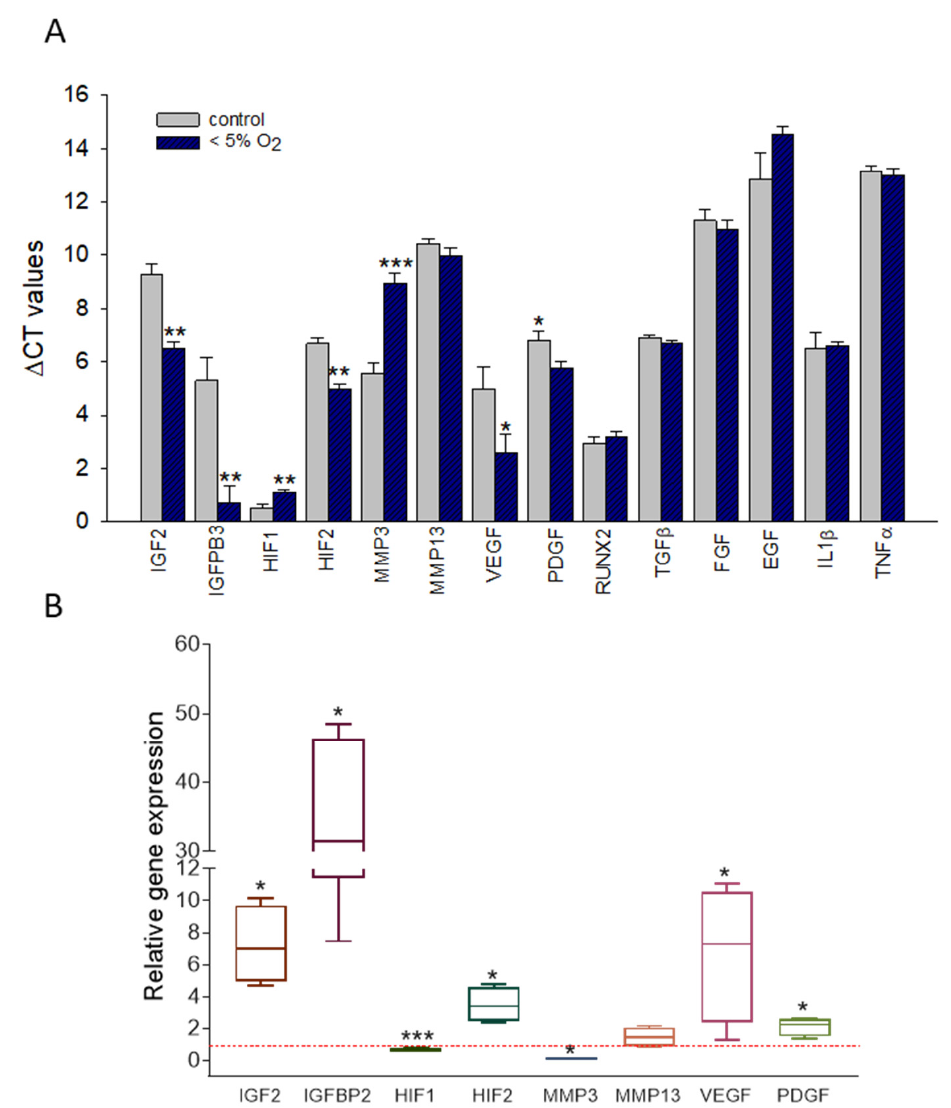
Figure 4. Evaluation of hypoxia induced changes in expression within the chondrocyte test system. The bar chart represents the averaged ∆ CT values of specific targets under normoxic and hypoxic conditions ( A ). Statistically significant differences, evaluated by the Student’s t -test, are labeled (*: p < 0.05; **: p < 0.01; ***: p < 0.001). Detailed picture of the change in expression induced by O 2 depletion as ratio (2 − ∆∆ Ct ) is given within a boxplot–calibrators were cells under normoxic conditions ( B ). Statistical difference was evaluated by the Mann–Whitney Rank Sum Test; *: p = 0.029, ***: p < 0.001. n = 4, measures is